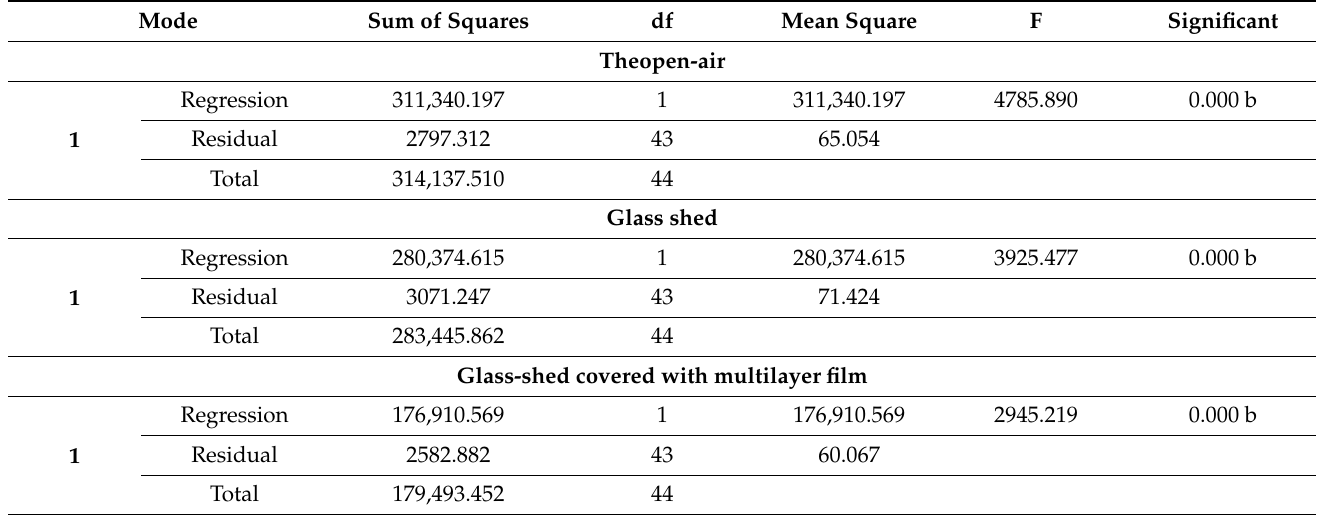
Table 7. The output of the SPSS shows a coefficients a table of the three treatments.